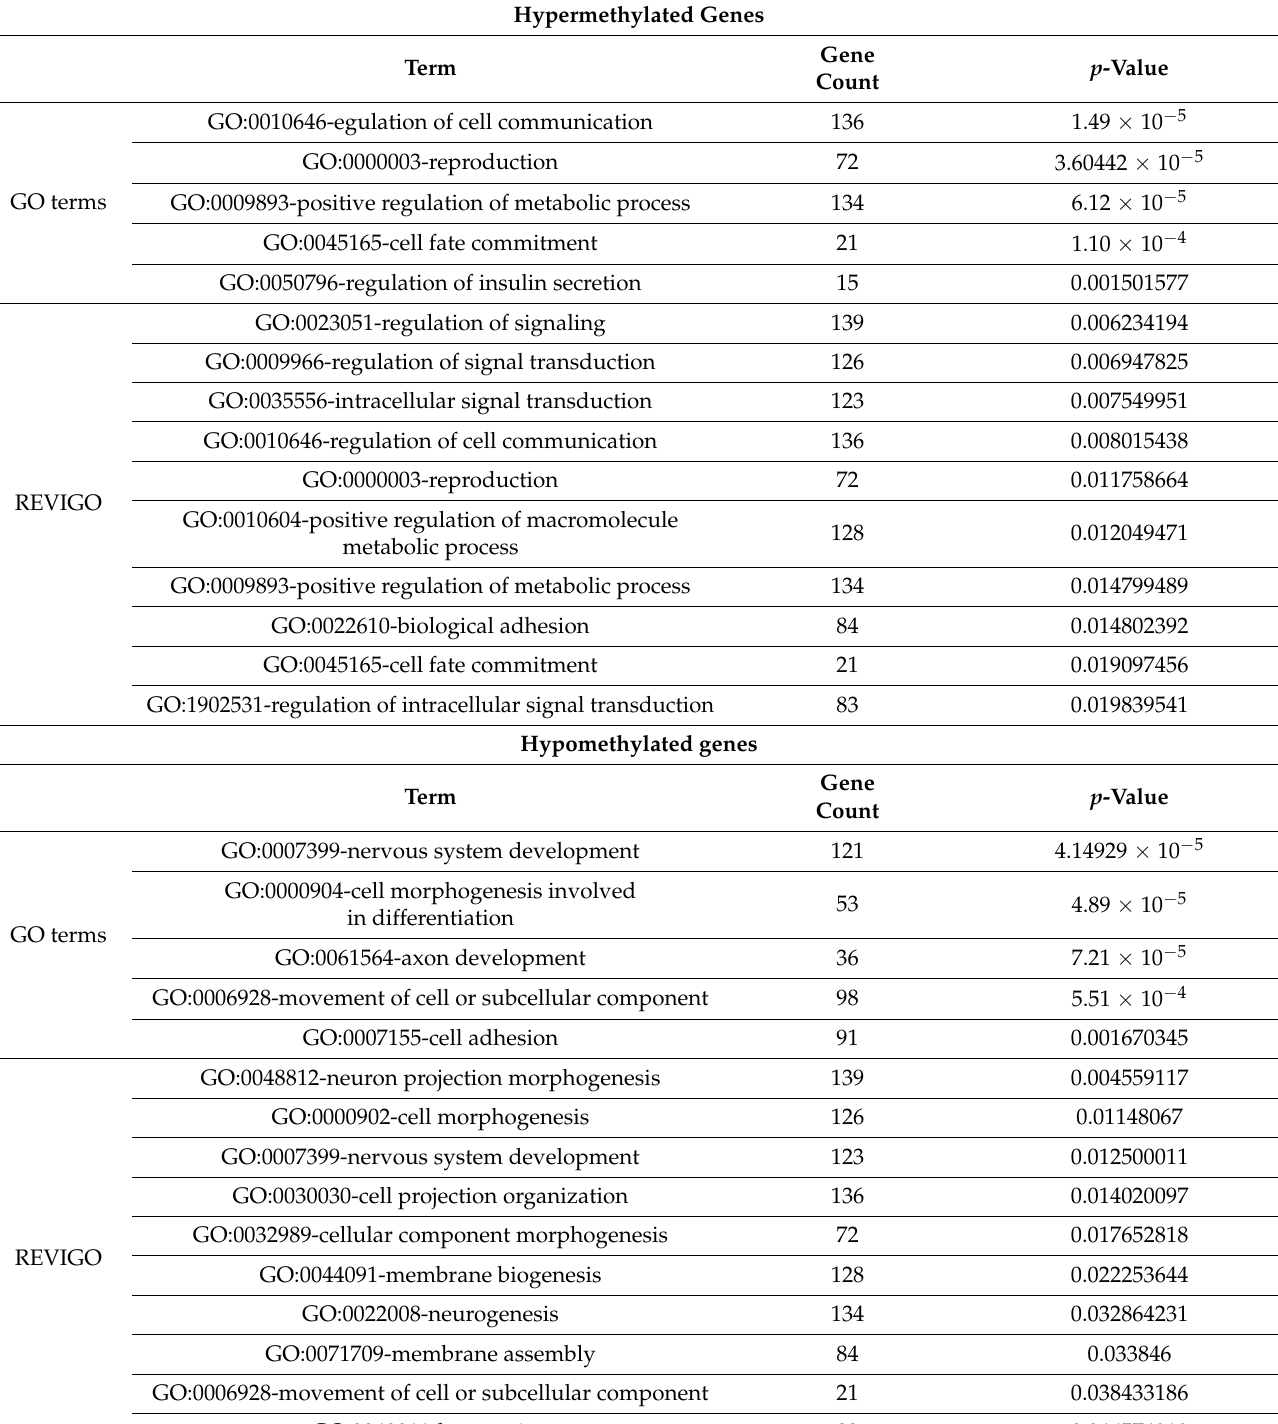
Table 1. Gene ontology and REVIGO terms of differentially methylated genes in hESC cultured in hyperglycemic (50 mM) condition compared to basal glucose (13.7 mM)